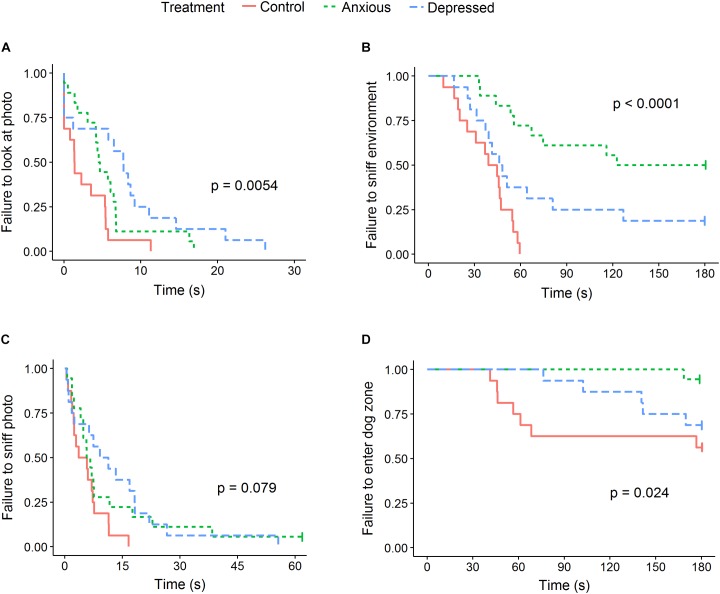
Kaplan–Meier curves for latency to look at the photo (A), sniff the environment (B), sniff the photo (C), and enter the zone closest to the dog (D). Each time an animal exhibited the given behavior, the probability on the Y-axis drops. Latencies to look at and sniff the photo are given for the first 60 s of testing only as no further events occurred after this time. The censored result in the anxious group for latency to sniff the photo remained censored for the duration of the 180 s test.